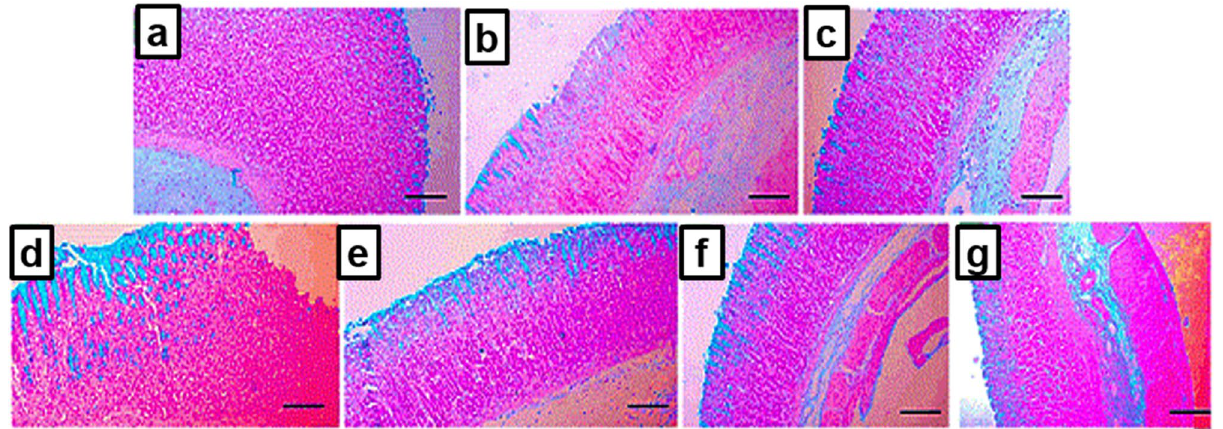
Figure 10. Histochemical staining of stomach sections of rats from the different treated groups with alcian blue stain to detect gastric mucus (X: 100). ( a ) N group, ( b ) ulcer group, ( c ) ome group, ( d ) plain group, ( e ) ALL group, ( f ) NanoAL group, and ( g ) NanoAH